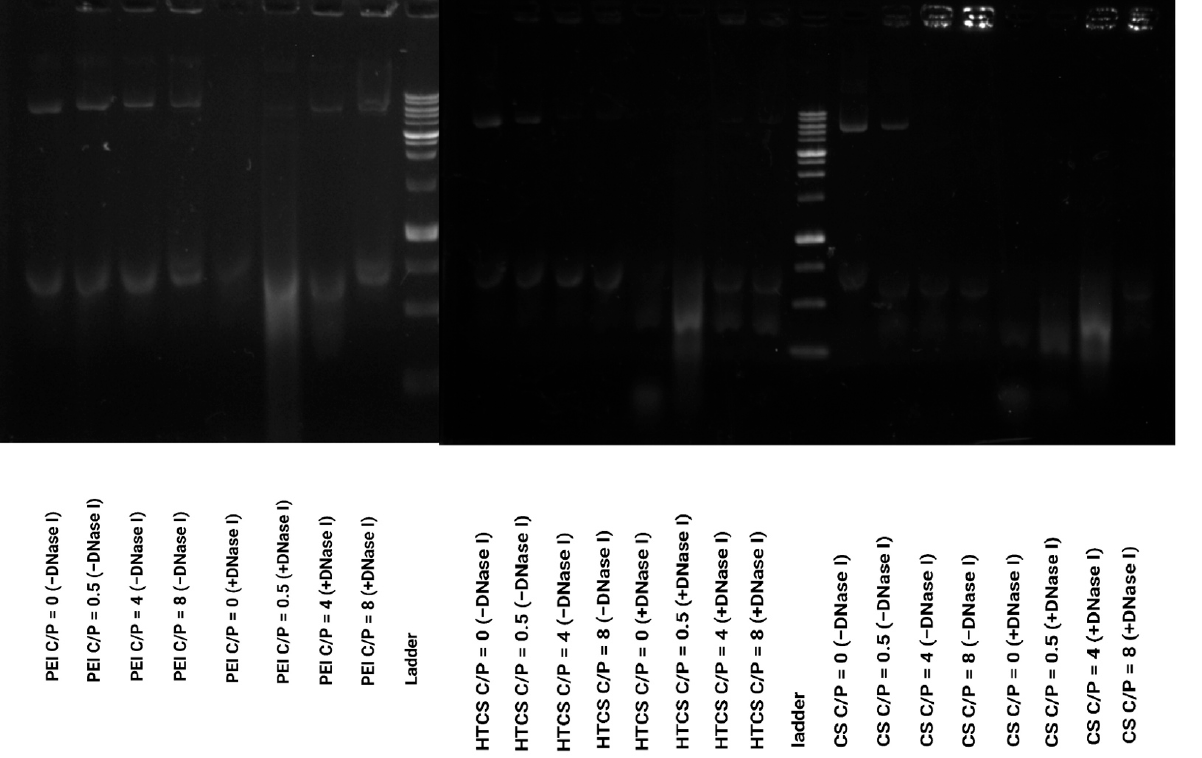
Figure 5. DNase I protection assay for PEI, CS, and HTCS. The polyplexes were treated with DNase I or PBS (negative control).